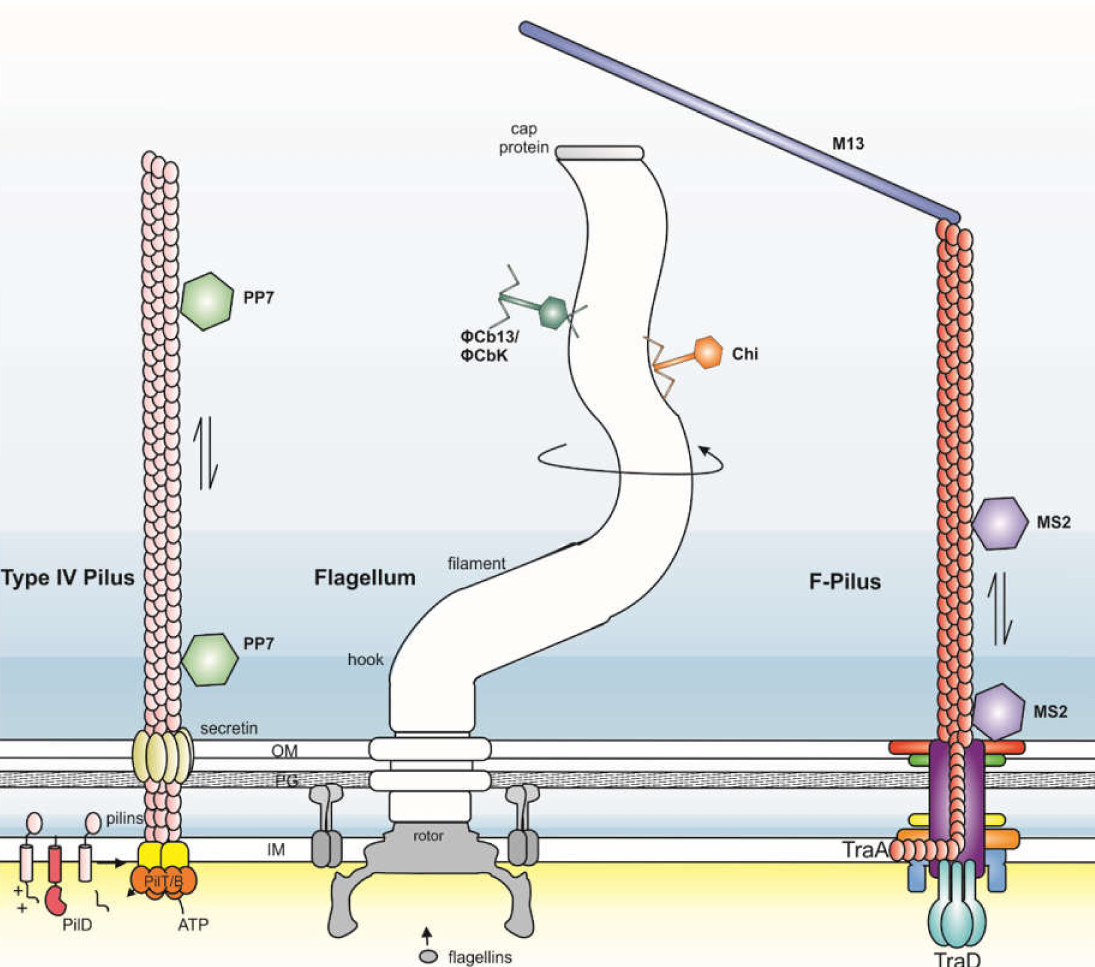
Figure 2. Schematic representation of viral interaction with filamentous structures on the surface of bacteria. The scheme represents the surface of a Gram-negative bacterium. From left to right a type IV pilus (Type II secretion), flagellum (Type III secretion) and F-pilus (Type IV secretion) are shown. (Left) Type IV pili consist of pilins (pink), which are N-terminally processed by PilD and inserted at the base of the growing filament with the help of the ATPase PilB. Secretins allow the